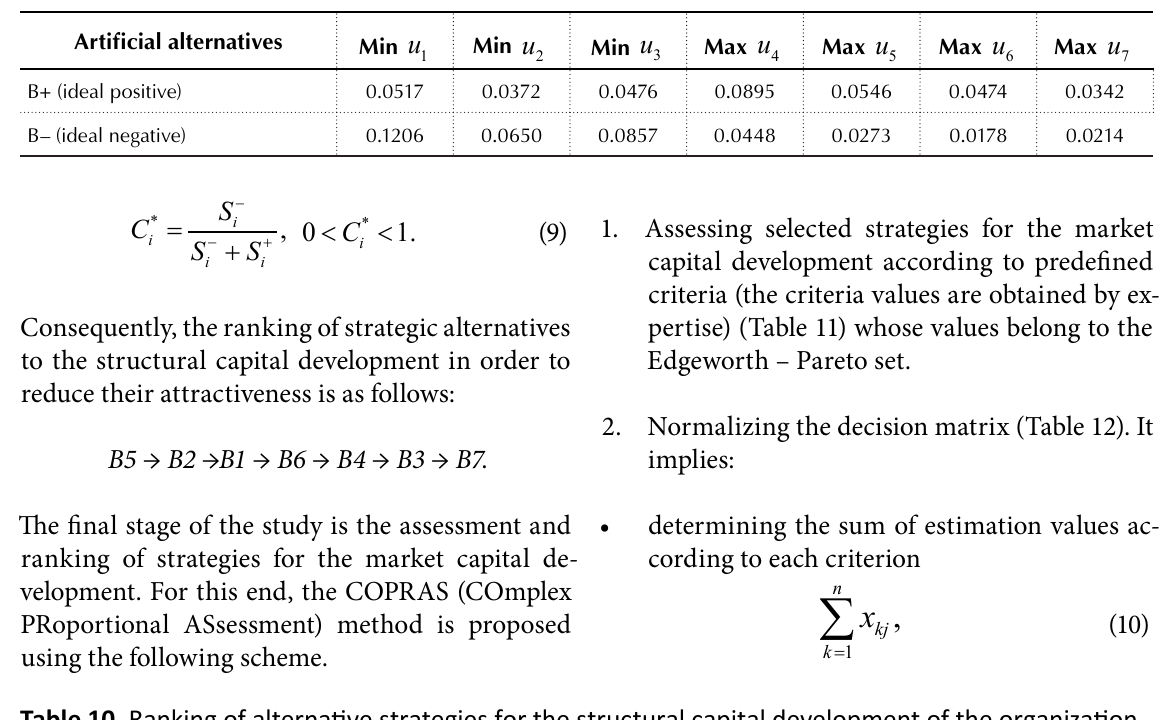
Table 9. Ideal positive and ideal negative matrix solution (artificial alternatives)